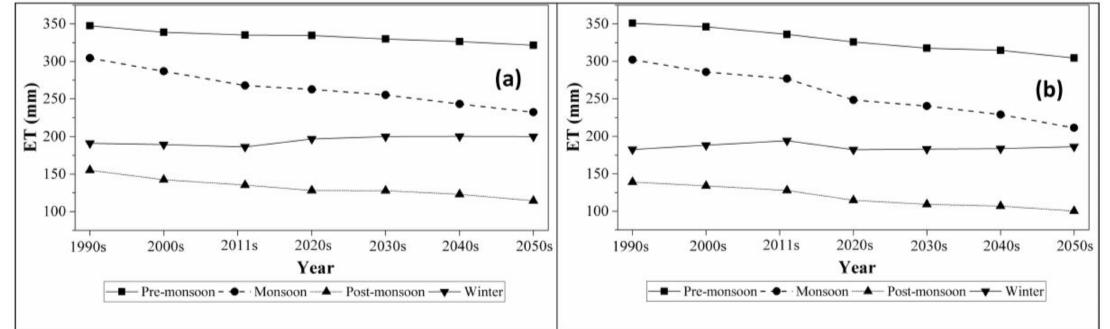
Figure 12. Climate and land use change impact on ET ( a ) RCP4.5; ( b )